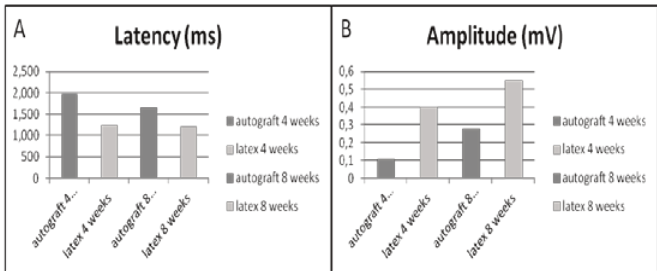
FIGURE 4 - Photomicrographs showing harvested nerve related with implant (left column), distal to implant (middle column), and muscle (right column), after embedding in paraffin. Rat implanted with autograft, after four weeks ( A , B and C ); rat implanted with latex conduit, after four weeks ( D , E and F ); rat implanted with autograft, after eight weeks ( G , H and I ); rat implanted with latex conduit, after eight weeks ( J , K and L ). Rats implanted with latex conduit show better quality of regenerated nerve. Rats implanted with autograft show muscle with atrophy and fibrosis. Toluidine Blue stain. Objective magnification: 40x.